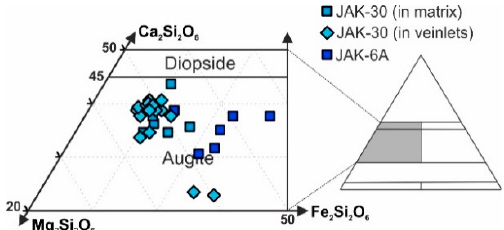
Figure 13. Classification diagram of magmatic clinopyroxene (Aug) from the Jaklovce Unit metabasalts and metadolerites.